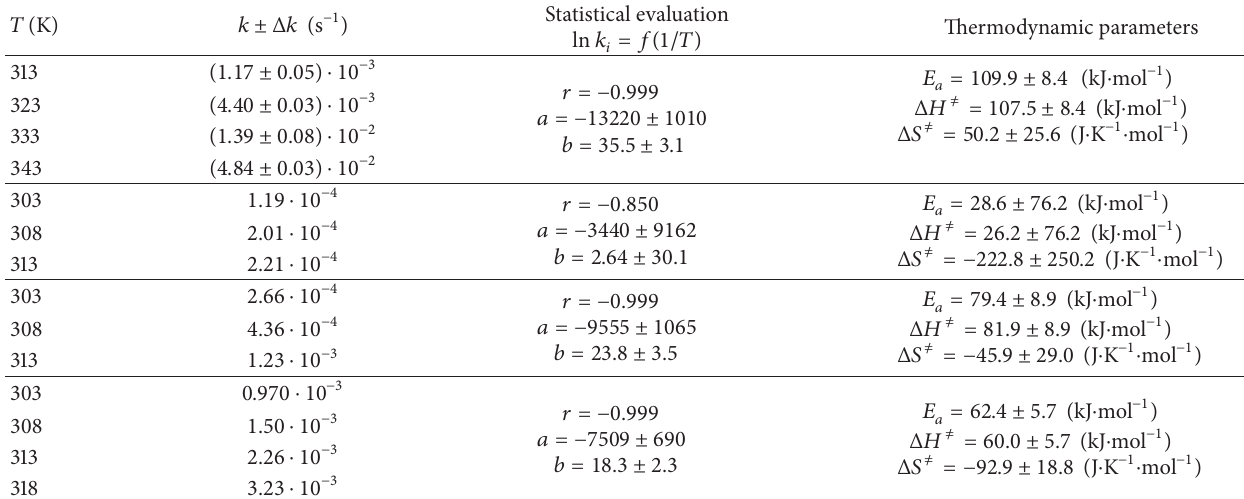
Table 1: Kinetic and thermodynamic parameters for the degradation of PPD in aqueous solutions.